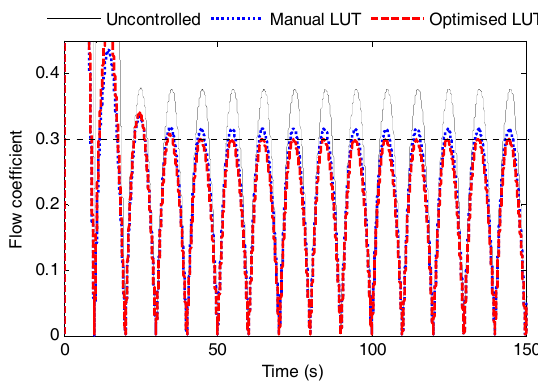
Figure 8. Input pressure for dP = | 7000 sin (0.314 t )| Pa . Technologies 2018 , 6 , x